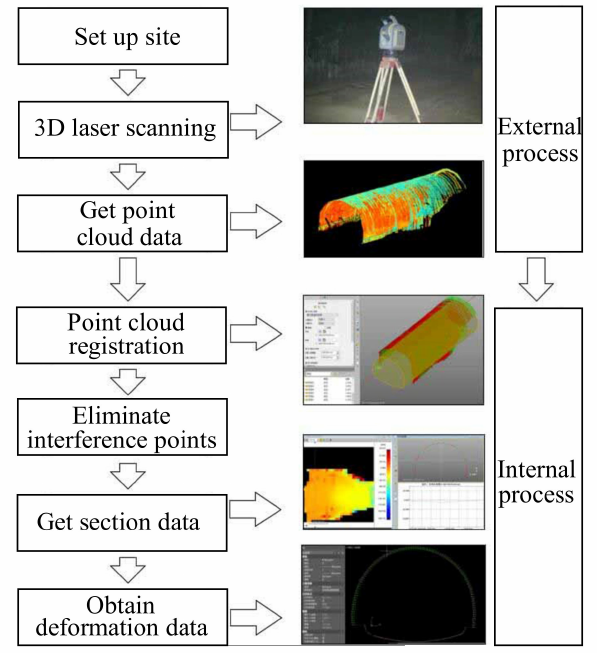
Figure 9. Three-dimensional laser scanning and data processing